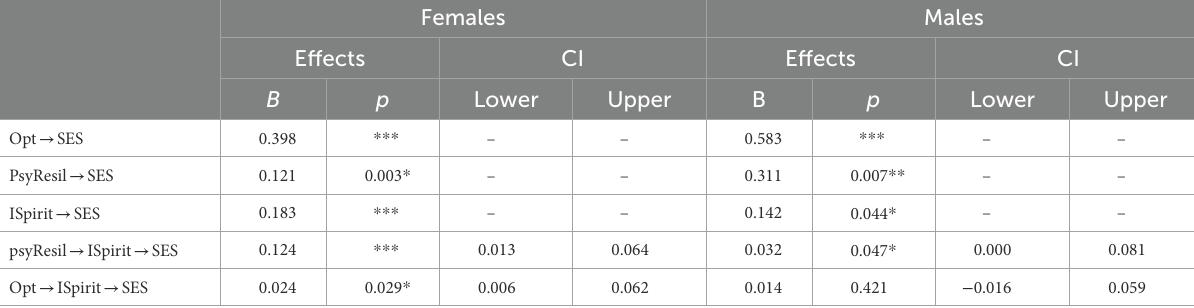
TABLE 4 Effects for path model by gender.